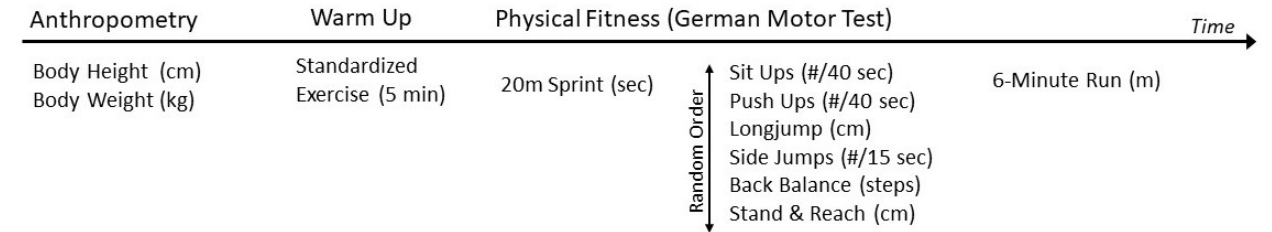
Figure 1. Data collection procedure at each measurement time. Body height (cm) was measured with a portable stadiometer (SECA ® 217, Hamburg,